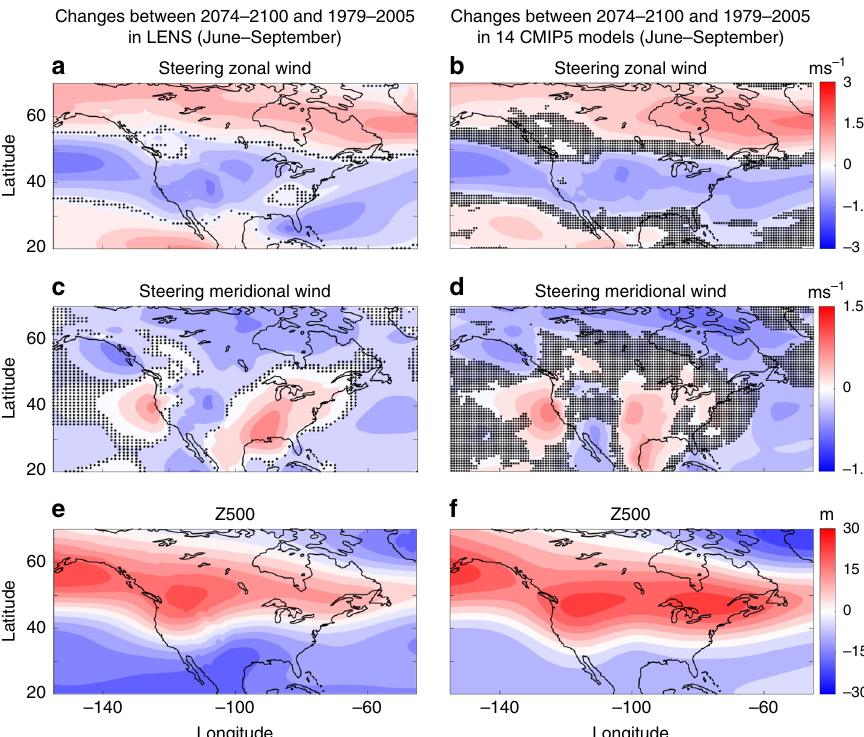
Fig. 2 Changes in the large-scale circulation and steering winds under climate change. Changes are computed as June to September averages in the period of 2074 – 2100 minus those in the period of 1979 – 2005. a , c , e : Using 40 ensemble members of National Center for Atmospheric Research ’ s Large Ensemble Community Project (LENS). Stars show where the difference is not statistically signi fi cant, based on a two-tailed t test at 95% level. A domain- averaged increase of 112.6 m is removed from geopotential height at 500 mb (Z500) for better illustration. b , d , f : Using multi-model-mean from 14 Coupled Model Intercomparison Project 5 (CMIP5) models. Dots show where fewer than 10 models (out of 14) agree on the sign of the change. A domain- averaged increase of 122.7 m is removed from Z500. See Methods for further details. See Supplementary Fig. 1 for the projected changes using 100 ensemble members of Max Planck Institute for Meteorology Grand Ensemble (MPI-GE), and using 20 ensemble members of Geophysical Fluid Dynamics Laboratory Large Ensemble (GFDL-LE). Supplementary Figs. 2 – 9 show similar plots but separately for each month of June to